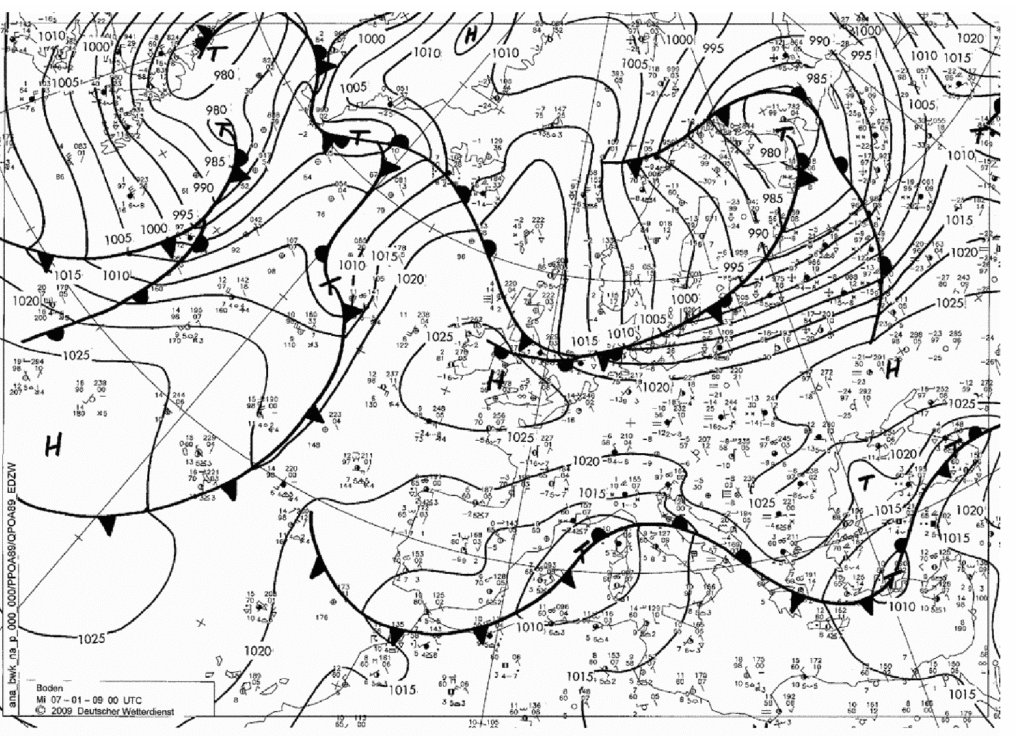
Figure 8. Weather map valid 00 UTC 7 January